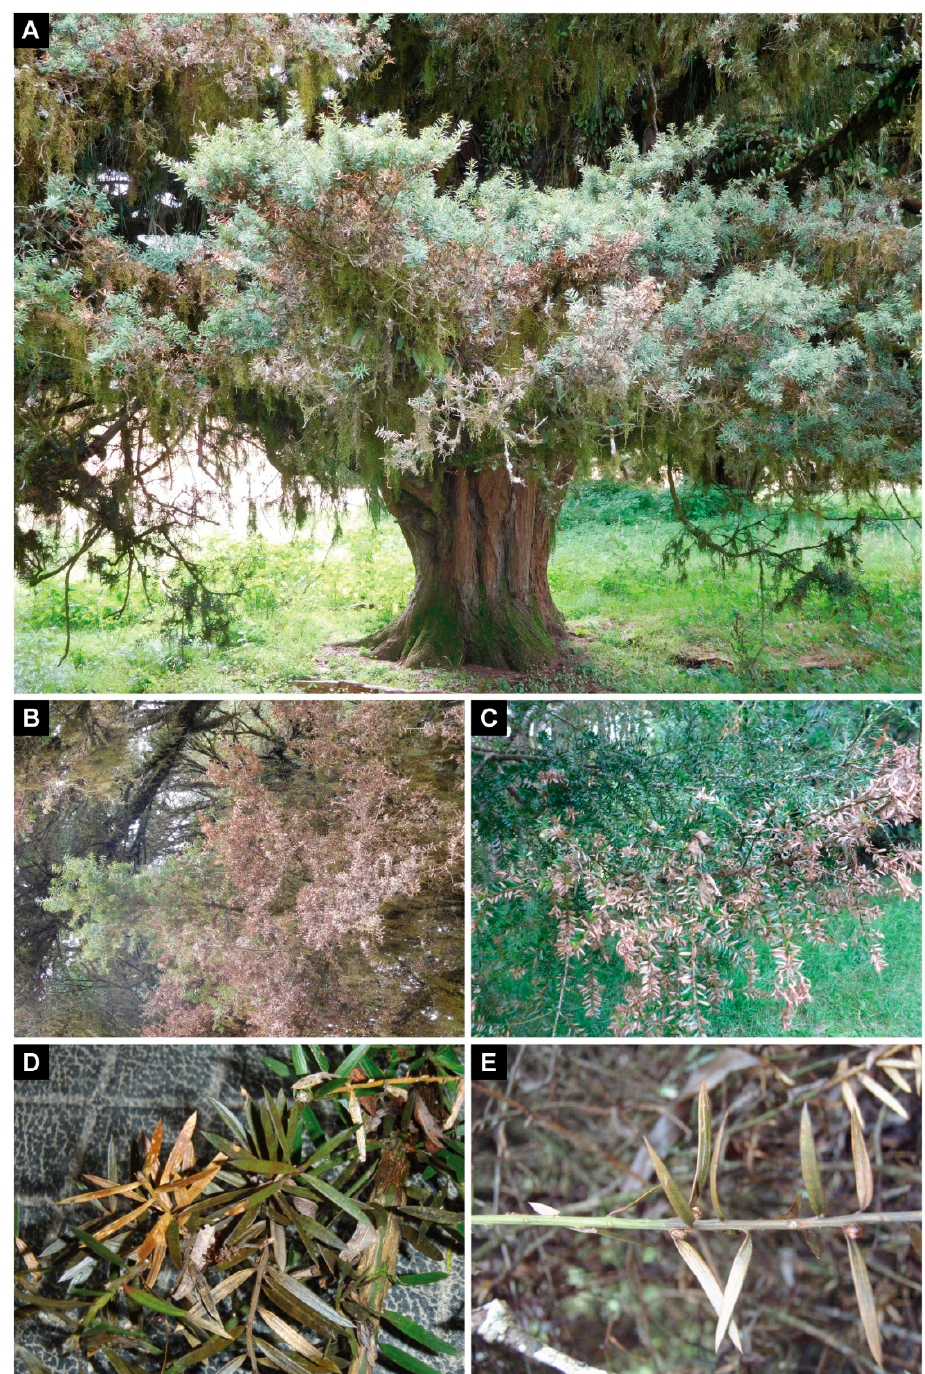
Figure 2. Symptoms of t¯otara needle blight on Podocarpus totara . ( A – C ) branches showing fire scorched appearance from shoot infections, ( D , E ) khaki and blackened colouration of infected needles and shoots.